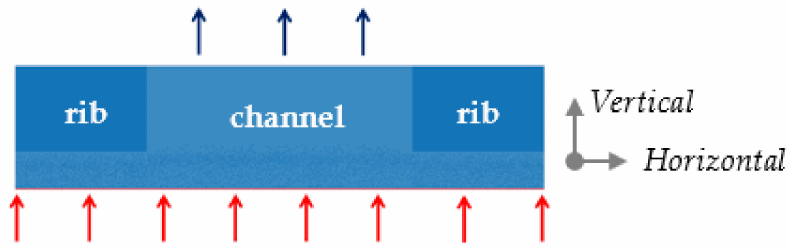
Figure 2. Reconstructed computational